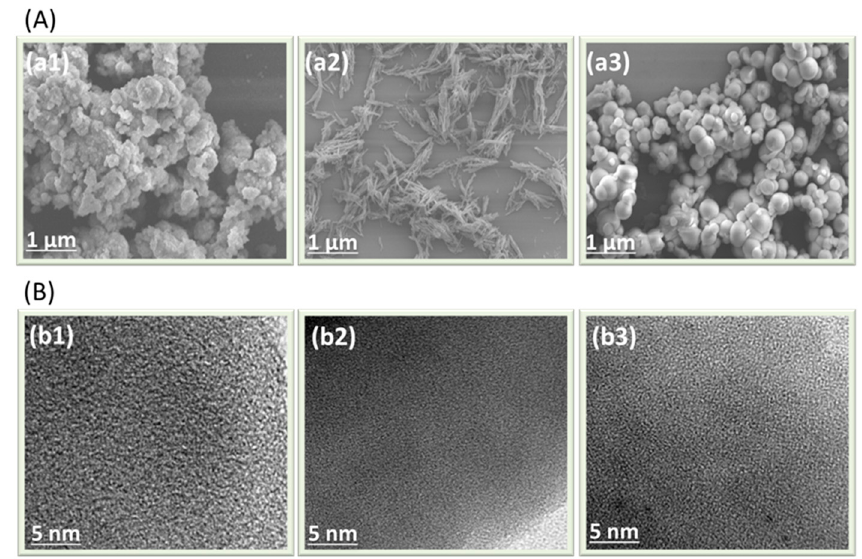
Figure 3. ( A ) SEM and ( B ) TEM images of the TPA–BBT–CMP ( a1 , b1 ), Py–BBT–CMP ( a2 , b2 ), and TPE–BBT–CMP ( a3 , b3 ).